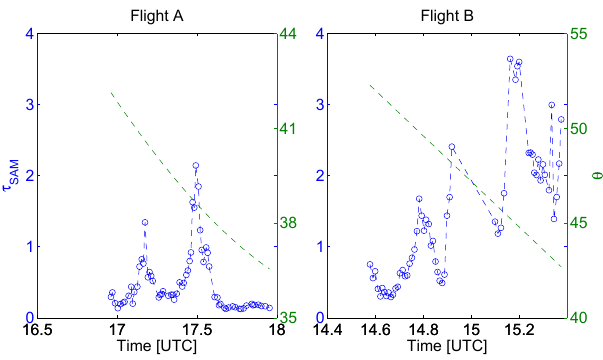
Figure 3. Optical thickness and solar zenith angle ( θ ) as a function of time during the flights A and B derived from the Sun and Aureole Measurements device at the SGP